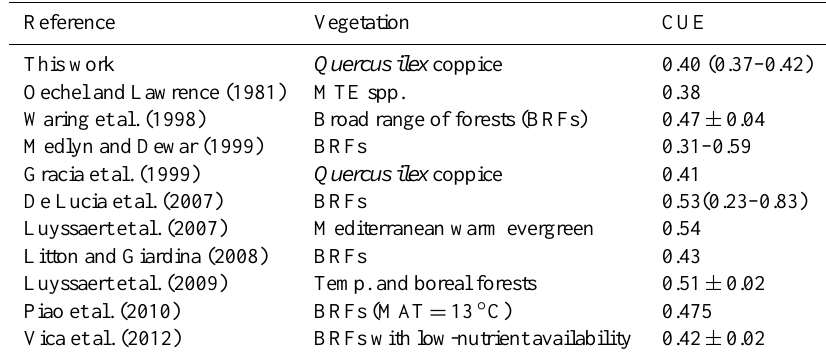
Table 2. Literature values of carbon use efficiencies (CUE) for a broad range of